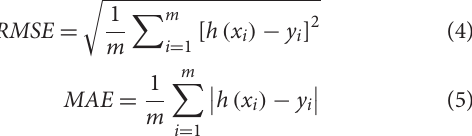
square error (RMSE), mean absolute error (MAE) and mean absolute percentage error (MAPE) (57). Formulas (4–6) below are used to calculate these evaluation